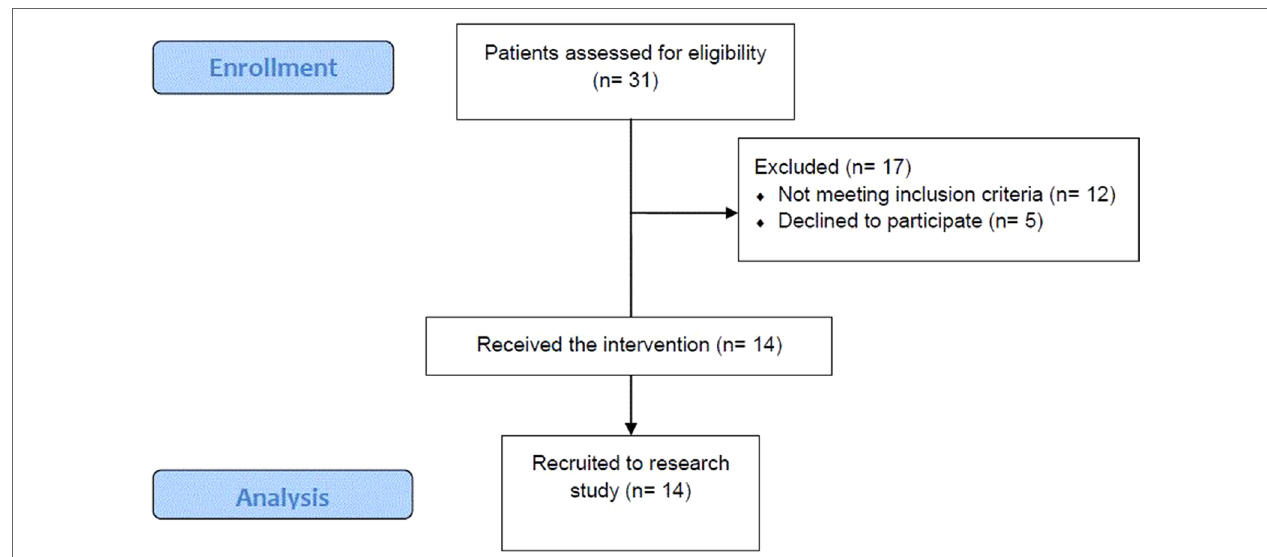
FIGURE 1 | Consort Flow